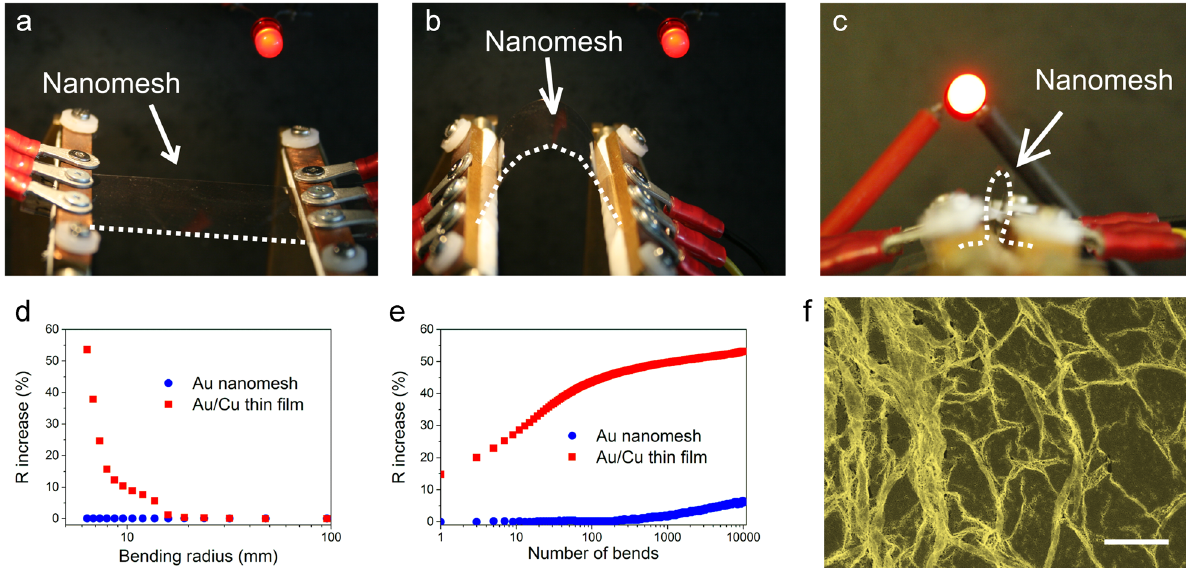
Fig. 3 Mechanical properties of the nanomesh electrodes. a – c Photographs of nanomesh electrode on fl exible PET substrate. The current through the nanomesh switches on the LED a before strain, b with Ɛ = 1.2% and c with Ɛ = 2.5%. d Increase of sheet resistance versus bending radius for bendable transparent electrodes consisting of gold nanomesh networks, for 5 nm Au-Cu fi lm with 17 at.% of Au on PET substrate. e Variation in resistance of the gold nanomesh electrode and Au-Cu fi lm on PET fi lm as a function of the number of cycles of repeated bending to a radius of 6 mm. f Typical SEM images of nanomesh after 10,000 bending cycles. The SEM images are representative of nanomesh bend after 10,000 cycles. White scale bar: 5 μ